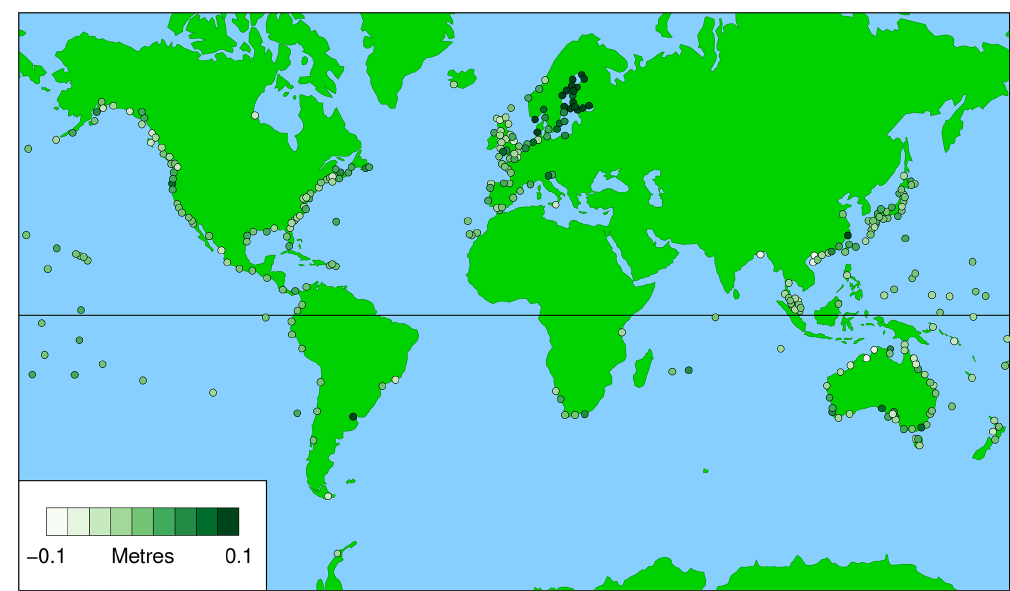
Figure 5. Averaged third metric , which is height of highest observed sea level on day of highest predicted tide for the year above highest predicted tide for the year, for civil days ( o c (I pc (j,k),j,k) − p c (I pc (j,k),j,k) ), averaged over all valid years, j .